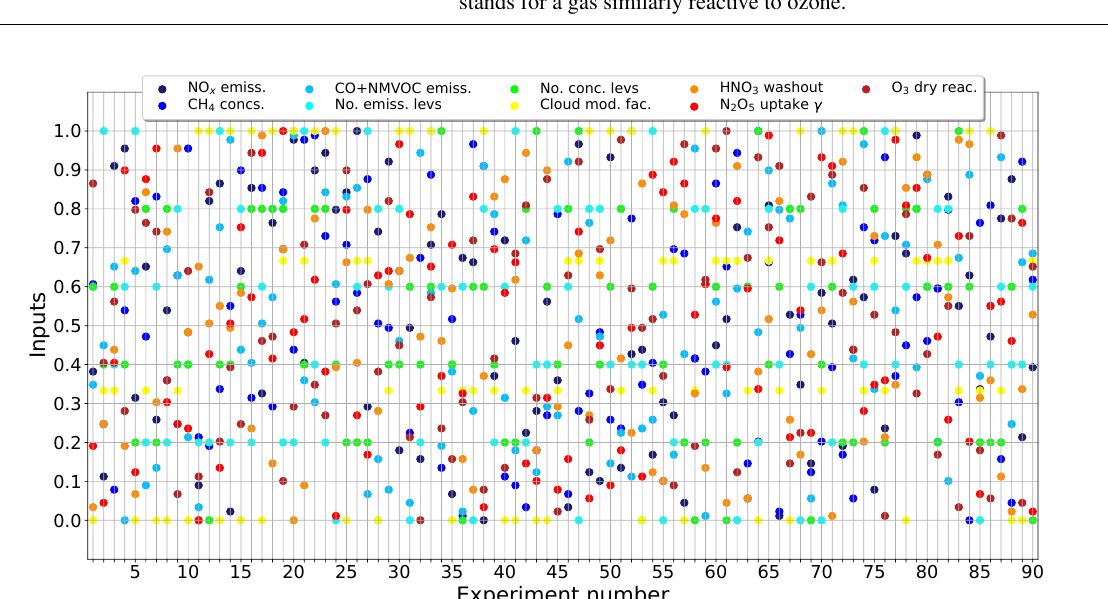
Figure 1. Experimental design for the 90 SOCOLv3.1 simulations performed to train the GP emulator. Each column of dots indicates the relative scaling applied to each of the nine variables – see Table 1 for more details. For clarity the inputs have been scaled between 0 and